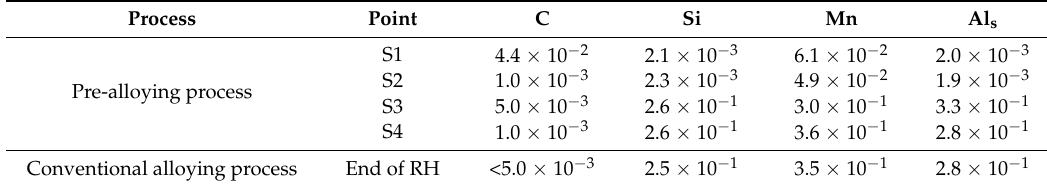
Table 1. Chemical compositions of steel samples (wt. %) in different stages of the pre-alloying process and in the final stage of the conventional alloying process.